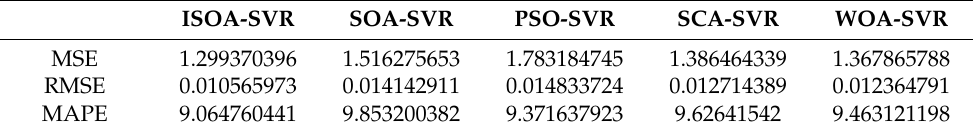
Table 7. The means square error (MSE), relative mean square error (RMSE) and mean percentage error (MAPE) index results of five models in Experiment 1.